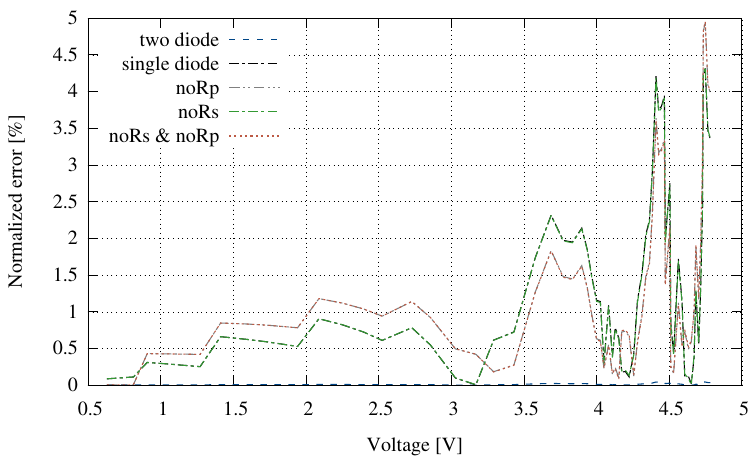
Figure 9. Normalized error obtained while reconstructing the Several I – V curve for Multicomp MC-SP-0.8 PV module with different model complexity.